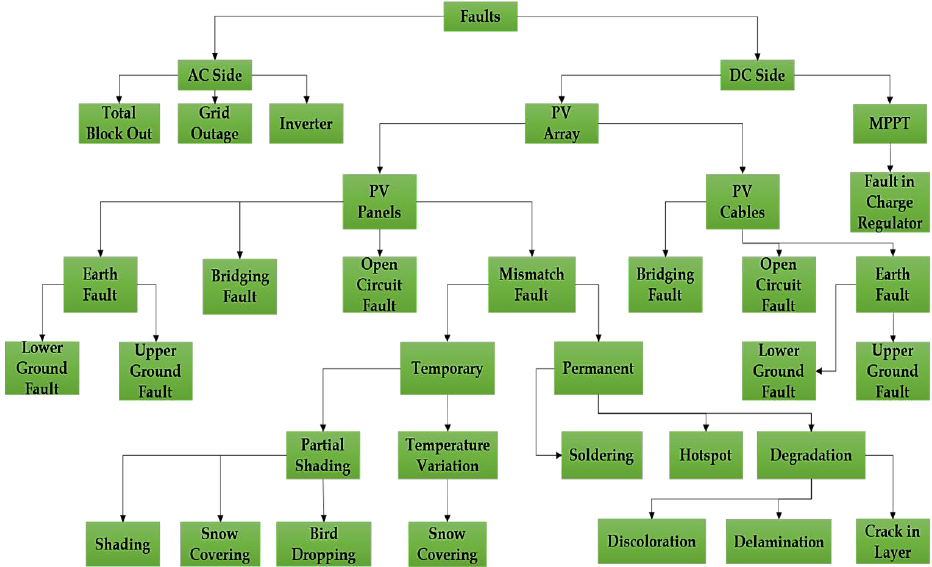
Figure 1. Classification of faults that occur in PV array panel.